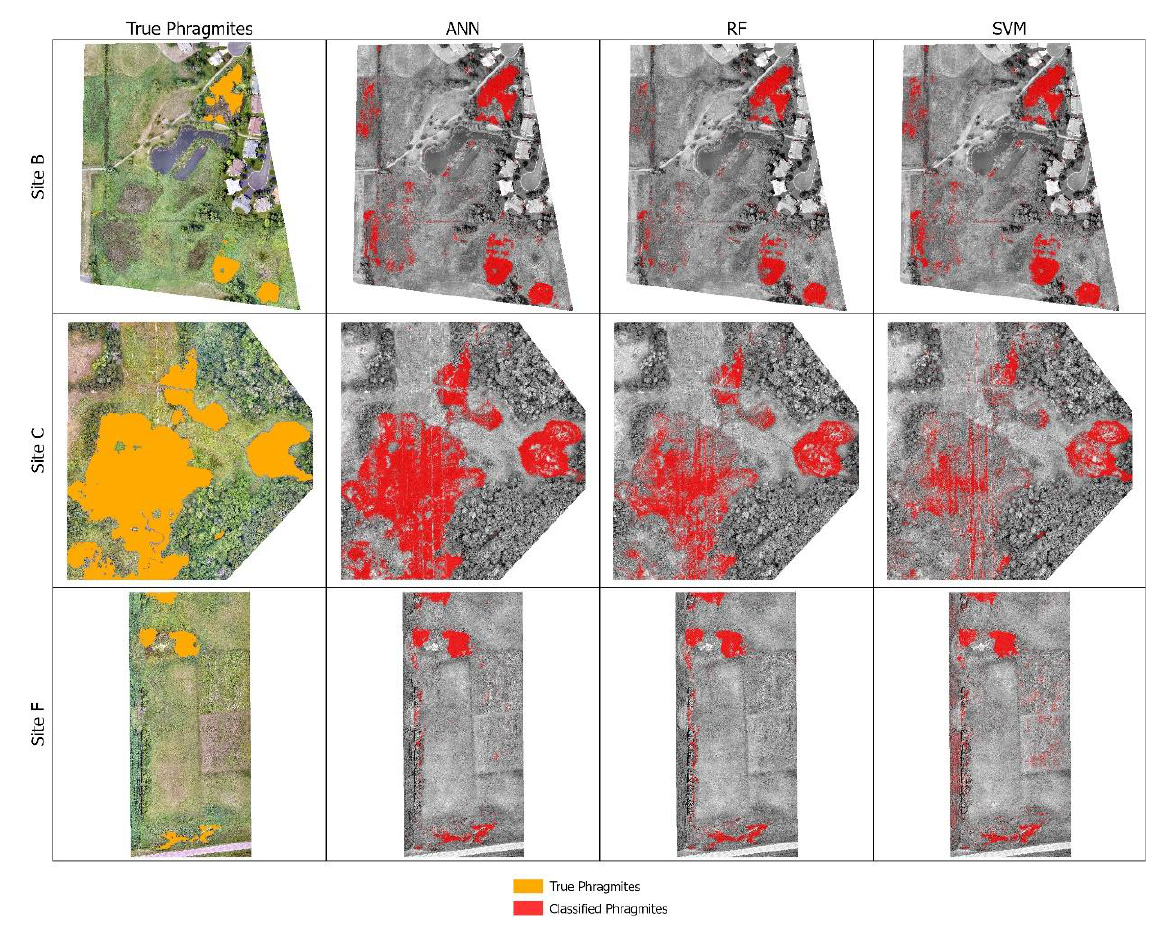
Figure 17. Classification of Phragmites (red) using an artificial neural network, random forest, and support vector machine without the final OBIA rule set at the three validation sites: Delano City Park (B), Chisago City property (C), and the Swan Lake Wildlife Management Area (F). Everything not identified as Phragmites was classified as Not Phragmites . The true Phragmites location is provided as a reference (orange).